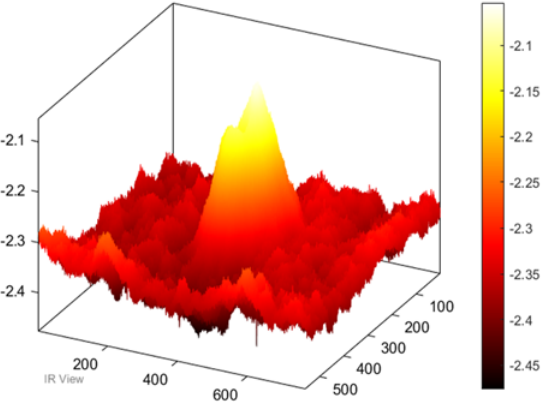
Figure 8. Three-dimensional image of the sample corresponding to PPT.